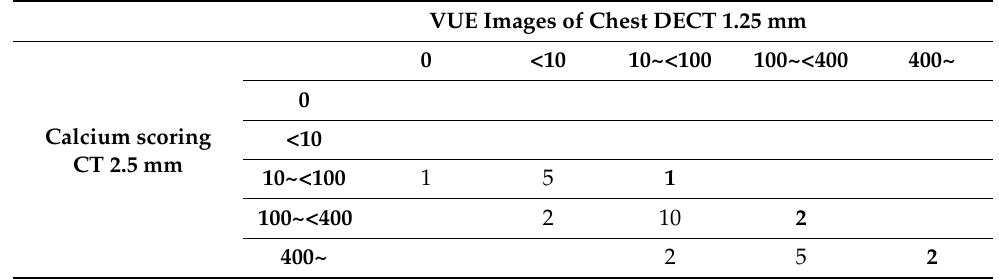
Table 4. Sectional analysis of CACS of CT and VUE images using chest DECT with 1.25 mm slice thickness.